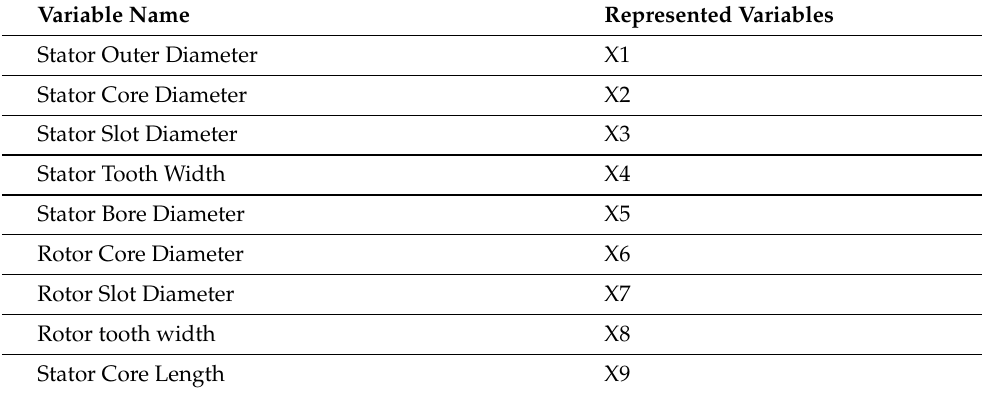
Table 4. Variables to be optimized.